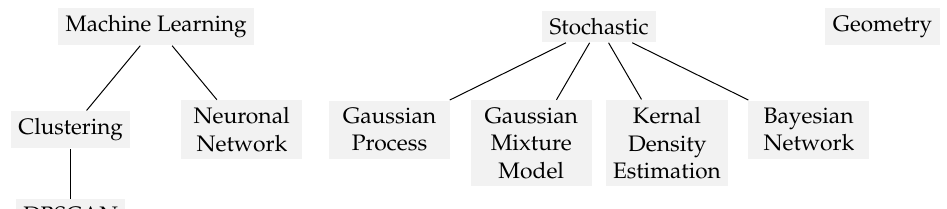
Figure 3. Classification of the underlying anomaly detection methods. Besides frameworks or miscellaneous approaches, most works can be grouped into one of the the major groups: machine- learning, stochastic, or geometry